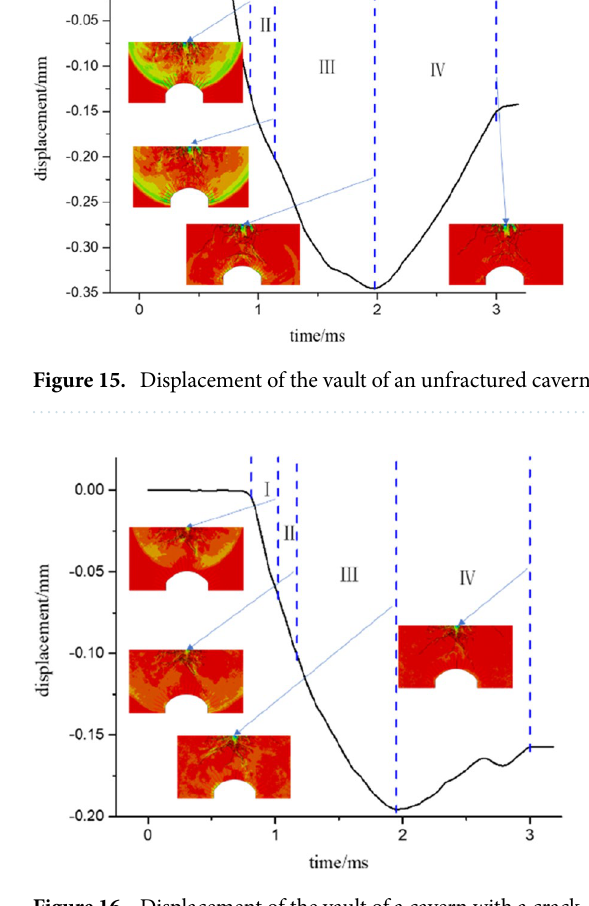
Figure 16. Displacement of the vault of a cavern with a crack.